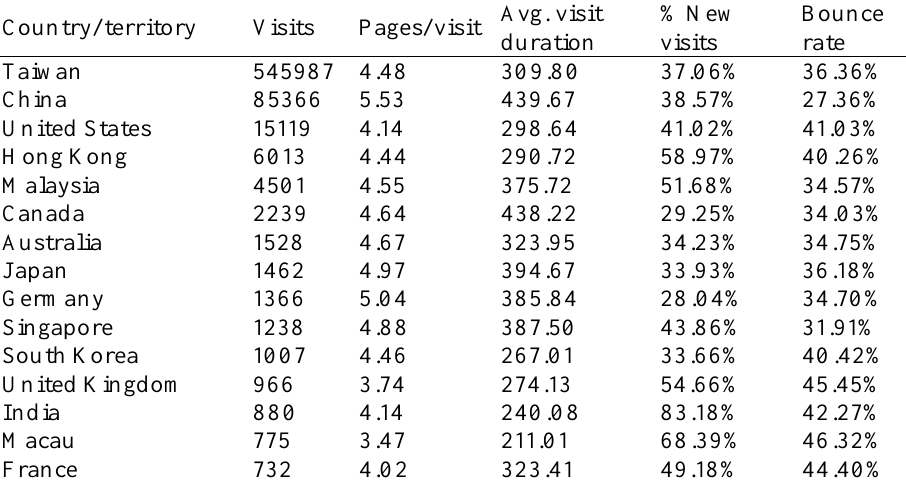
Top 15 National Information of the Visitors